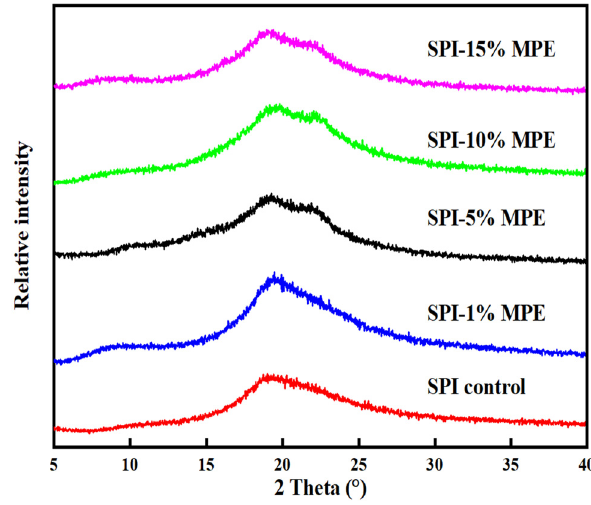
Figure 9: XRD di ff raction patterns of SPI fi lms with and without